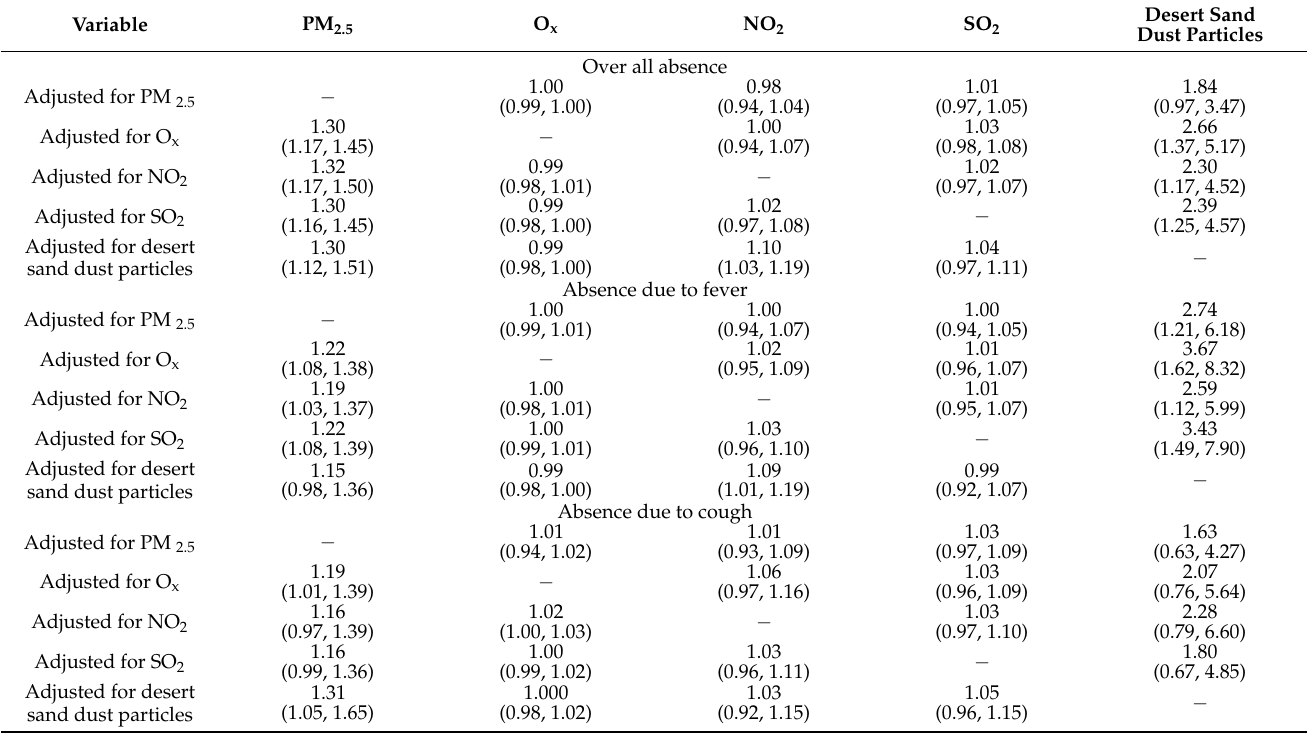
Table 7. Estimated relative risk and 95% confidence interval for absence associated with a 10- µ g/m 3 increase in PM 2.5 , a 1-ppb in NO 2 , SO 2 and O x and a 0.1-km − 1 in desert sand dust particles at lag1 in two-pollutant models.